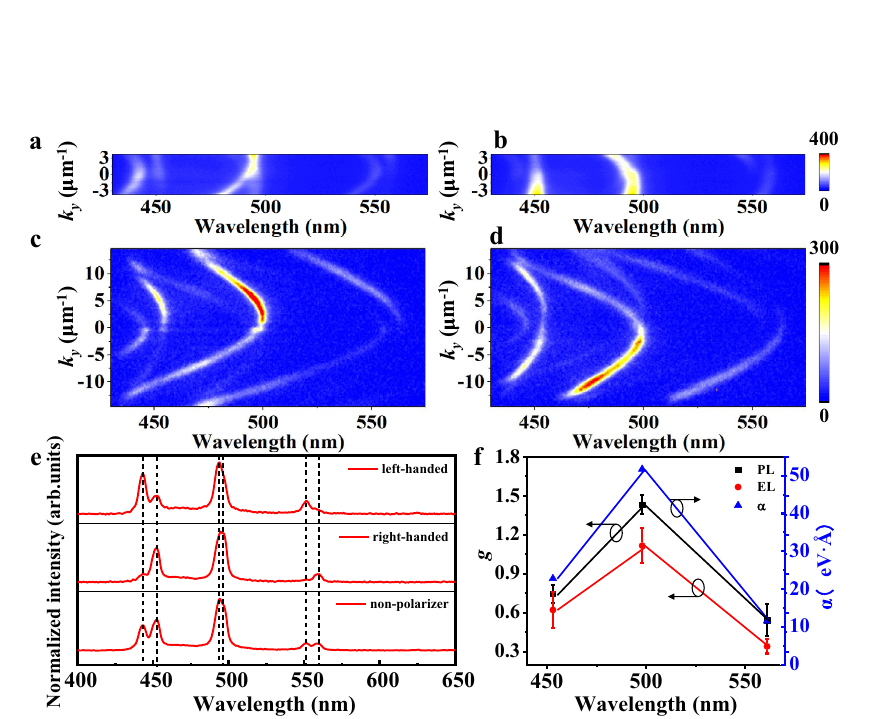
Fig. 3 | EL architecture and performances. a Energy level diagram of the device. b Photomicrographofthe 6M-DSB single-crystalOLED array under EL. c Upper:PL spectrum of the 6M-DSB crystal. Middle: spectrum of the crystal edge waveguide under EL as shown in b . Lower: spectrum of light emanating from the microcavity